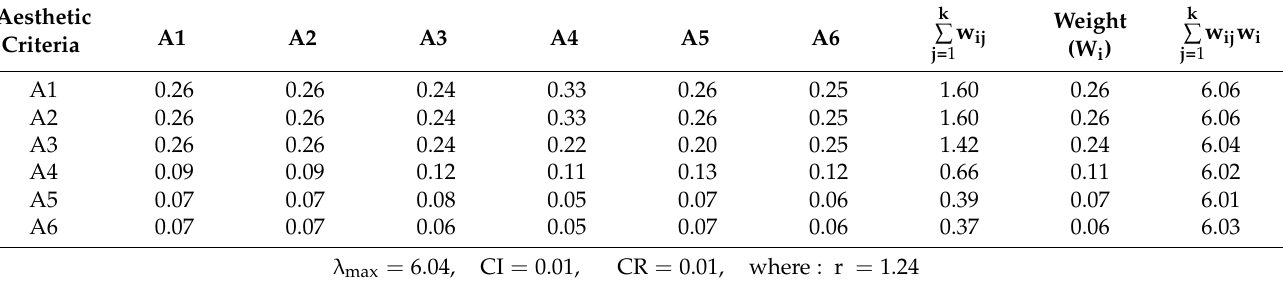
Table 11. Weights for aesthetic criteria of PV. Own study.